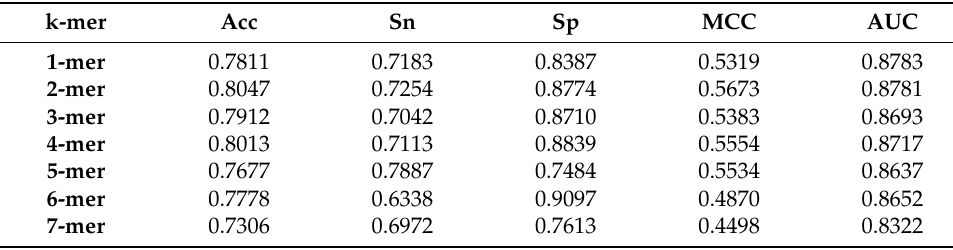
Table 1. Performance comparison of different k-mers on the test dataset. The performance of individual k-mer